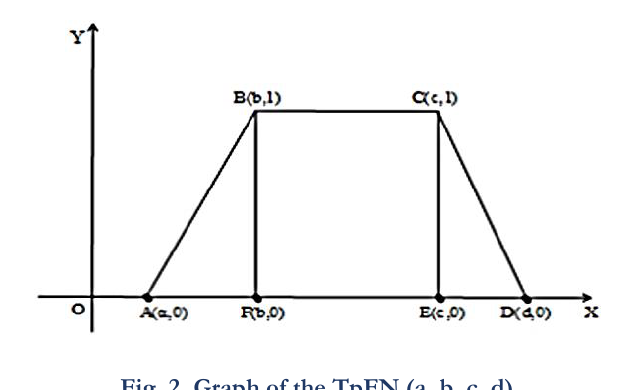
Fig. 2. Graph of the TpFN (a, b, c,